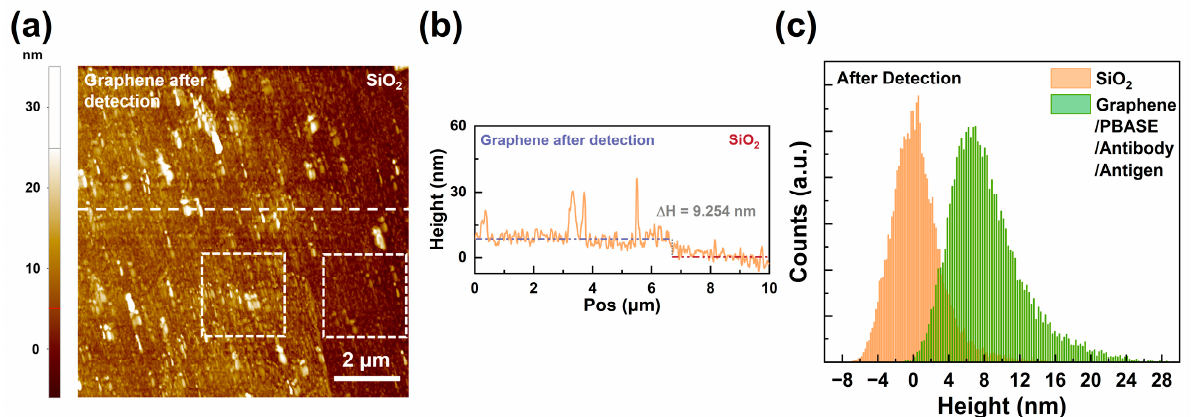
Figure 4. AFM characterization of graphene morphology after the detection of SARS-CoV-2 antigen protein, and the corresponding height profile and histograms. ( a ) The AFM image of graphene film and SiO 2 substrate after the antigen detection. ( b ) The height profile along the white dashed line in ( a ). ( c ) The histograms of the height of graphene and SiO 2 substrate after the antigen detection. The histograms are extracted from the white dashed boxes in ( a ) and the area of each box is 2.5 × 2.5 µ m 2 .